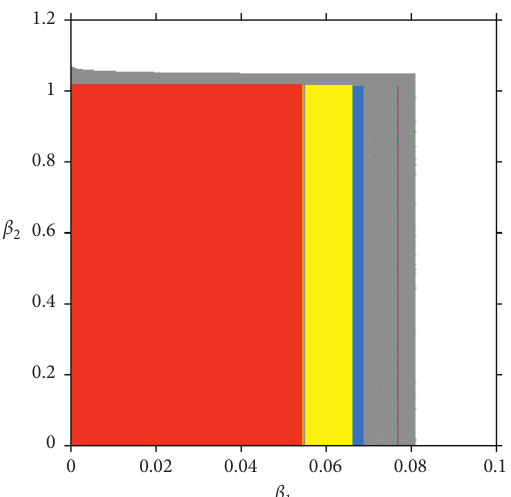
Figure 21: 2D parameter bifurcation in the ( β